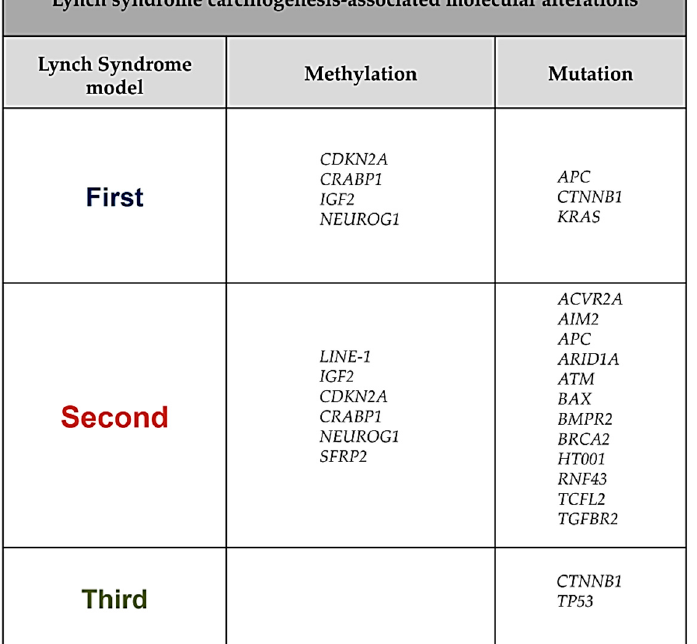
Figure 3. List of potential molecular markers that could be analyzed non-invasively for methylation or mutational status by testing distant media (stool or blood).